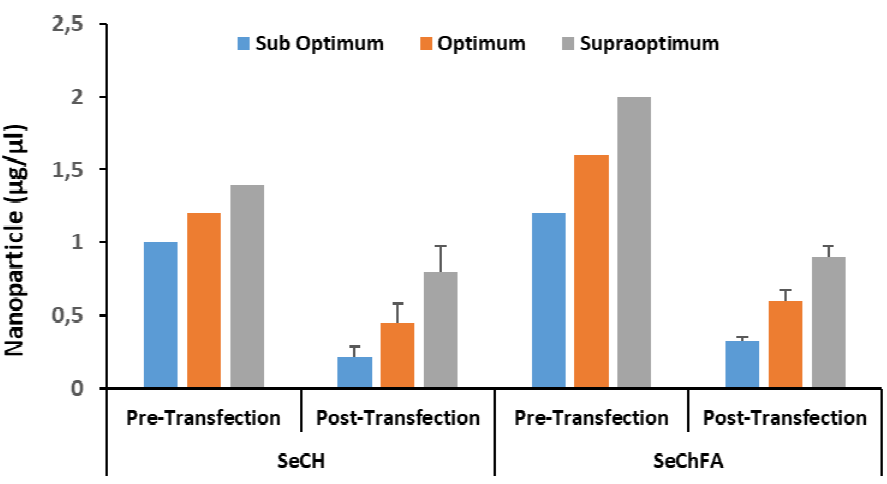
Figure 9. The concentration of selenium determined by ICP-OES before (pre − ) and after (post − ) transfection in HeLa ‐ tat ‐ Luc cells.